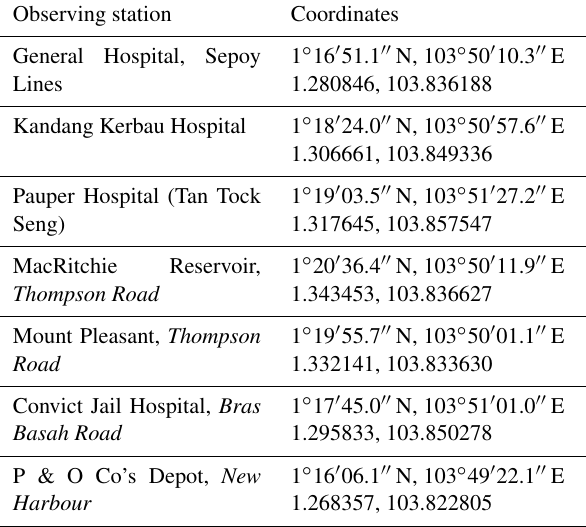
Table 2. Observing stations and coordinates used for the WRF anal-